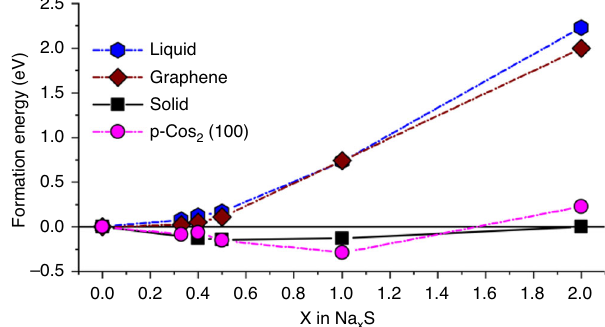
Fig. 7 Convex energy hull of Na 2 S y phases per mol of S ( x = 2/ y ) from DFT calculations. Energy of solid Na 2 S y structures is shown with black symbols relative to end-member compositions of solid Na 2 S and S. The energies of molecular Na 2 S y geometries bound to the p-CoS 2 (100) surface (magenta), graphene surface (brown) and in the free liquid state (blue) with implicit solvation are shown with dashed